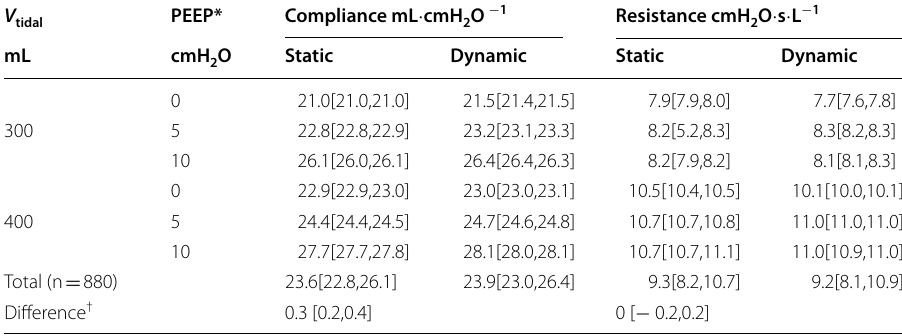
Table 1 Respiratory system’s static compliance and resistance values calculated by the static and dynamic methods using a test